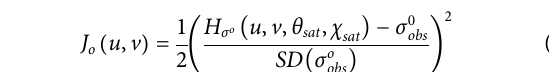
FIGURE 1 | Comparison of the CMOD4, CMOD_IFR2, CMOD5, and CMOD5. N NRCS simulations as a function of (A) wind speed (wind direction of 0 ° ) and (B) wind direction (wind speed of 12 m/s).